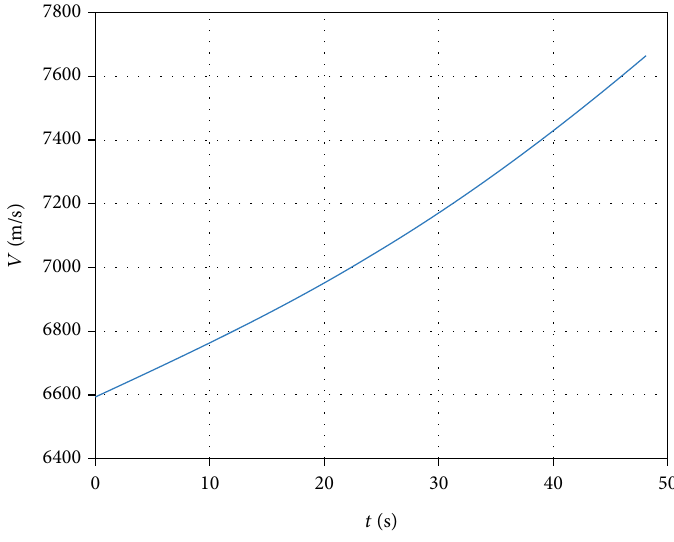
Figure 3: Time history of the velocity.